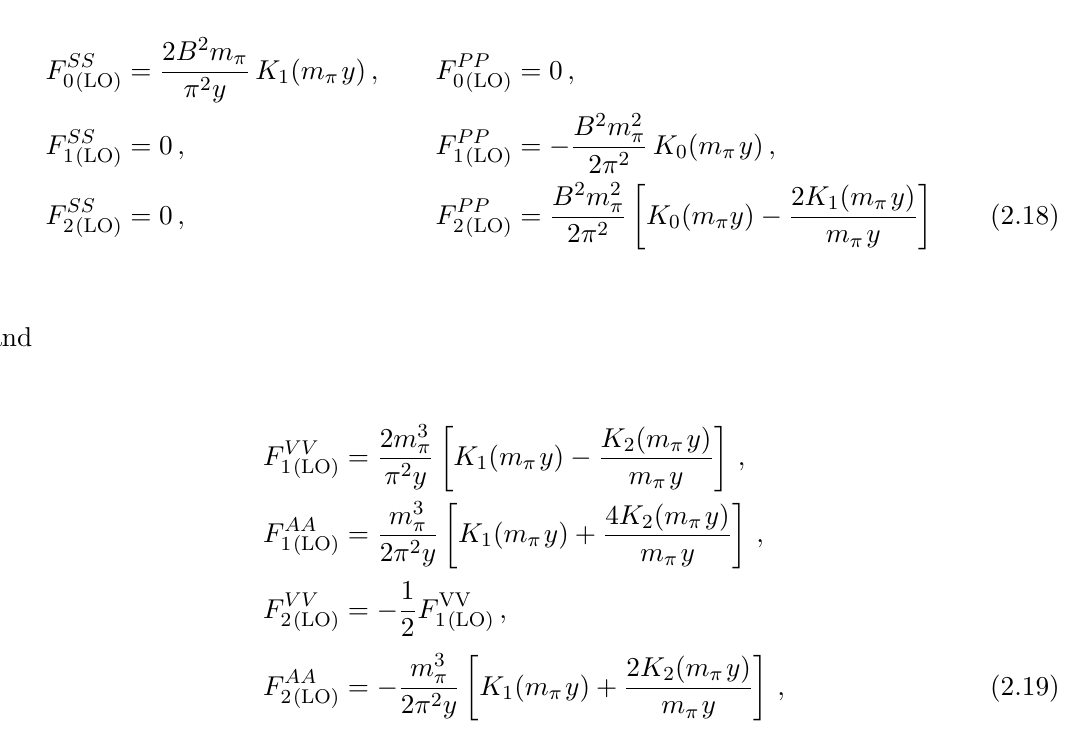
Figure 1. Graphs for the matrix elements theory. Single lines denote pions, double lines resonances, and crossed circles indicate current insertions. The leading-order chiral Lagrangian gives rise to graph (a) for graphs (b) and (c) for any of the four matrix elements, depending on the quantum numbers of the